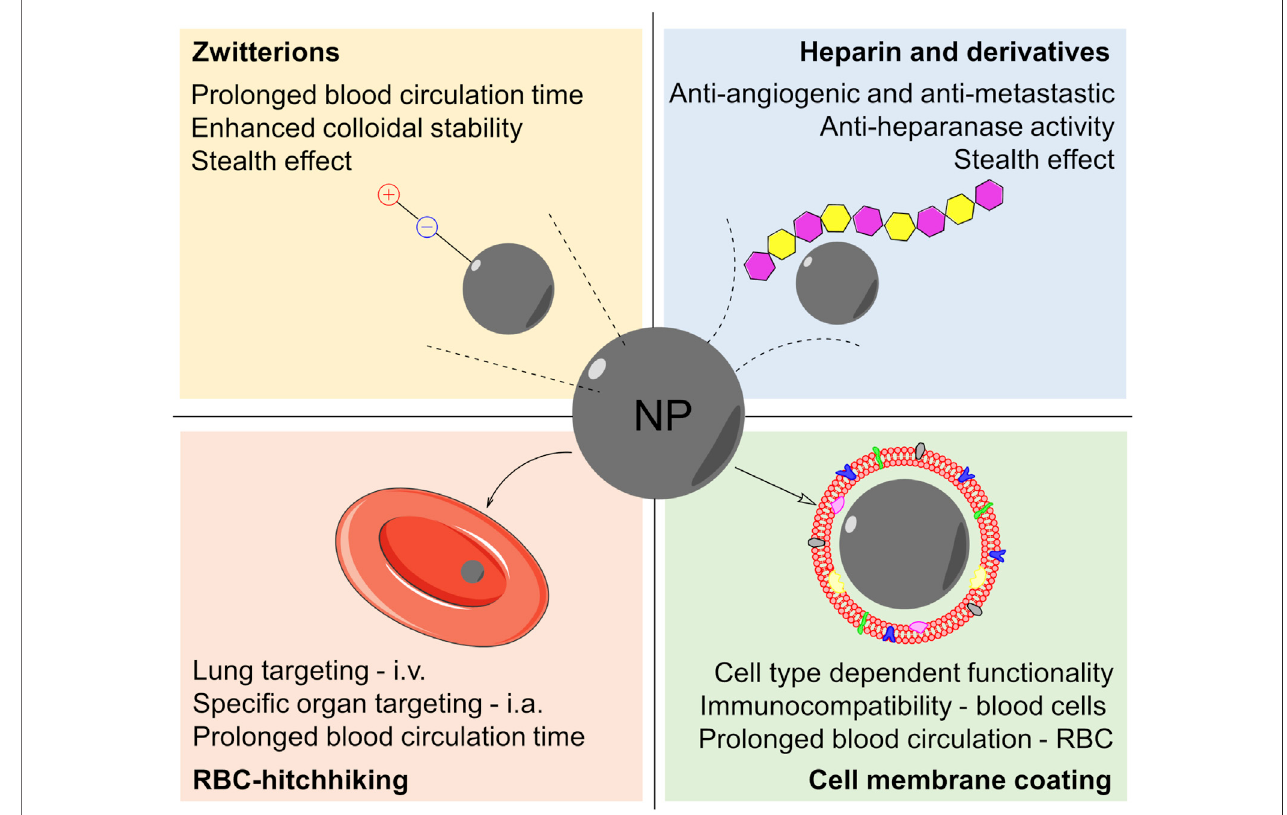
FIGURE 4 | Scheme summarizing the most promising surface chemistry approaches for the preparation of NBMs for cancer theranostics: coating the nanoparticles (NP) with zwitterions, heparin and its derivatives, cell membranes, or red blood cells (RBC) adhesive molecules (RCB-hitchhiking). Also, some of the advantages are listed for each approach. Abbreviations: i.v-intravenous injection via; i.a-intra-arterial injection via.